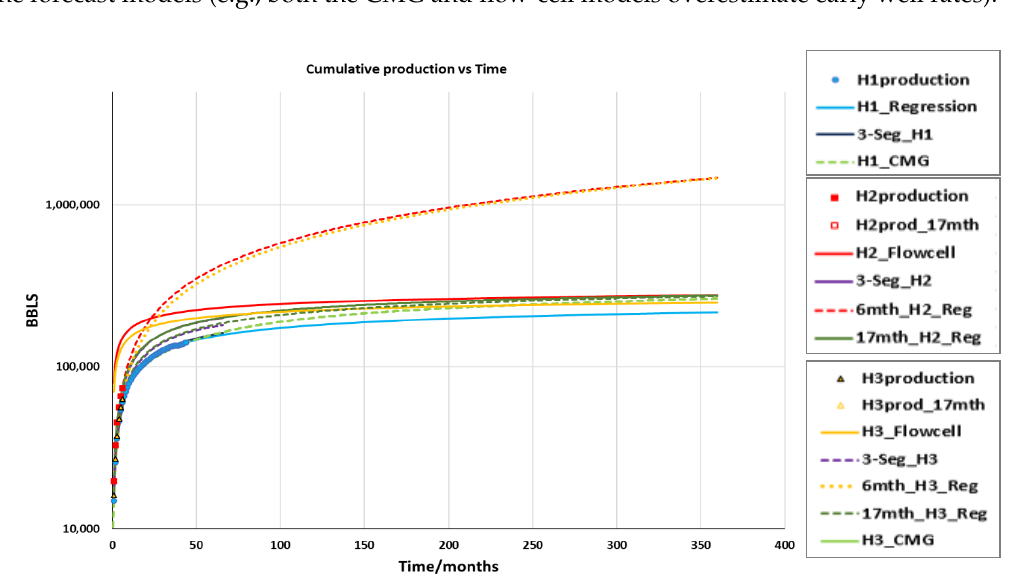
Figure 6. Comparison of wells H1, H2, and H3 cumulative production data with long-term production forecasts from 1) Arps regressions (using both 6 months and 17 months production data), 2) Analytical flow-cell model, 3) 3-segment Decline Curve and 4) CMG model (for H1 and H3 wells only). Legend explained as follows (each box represents curves modeled for a single well): H1production —44